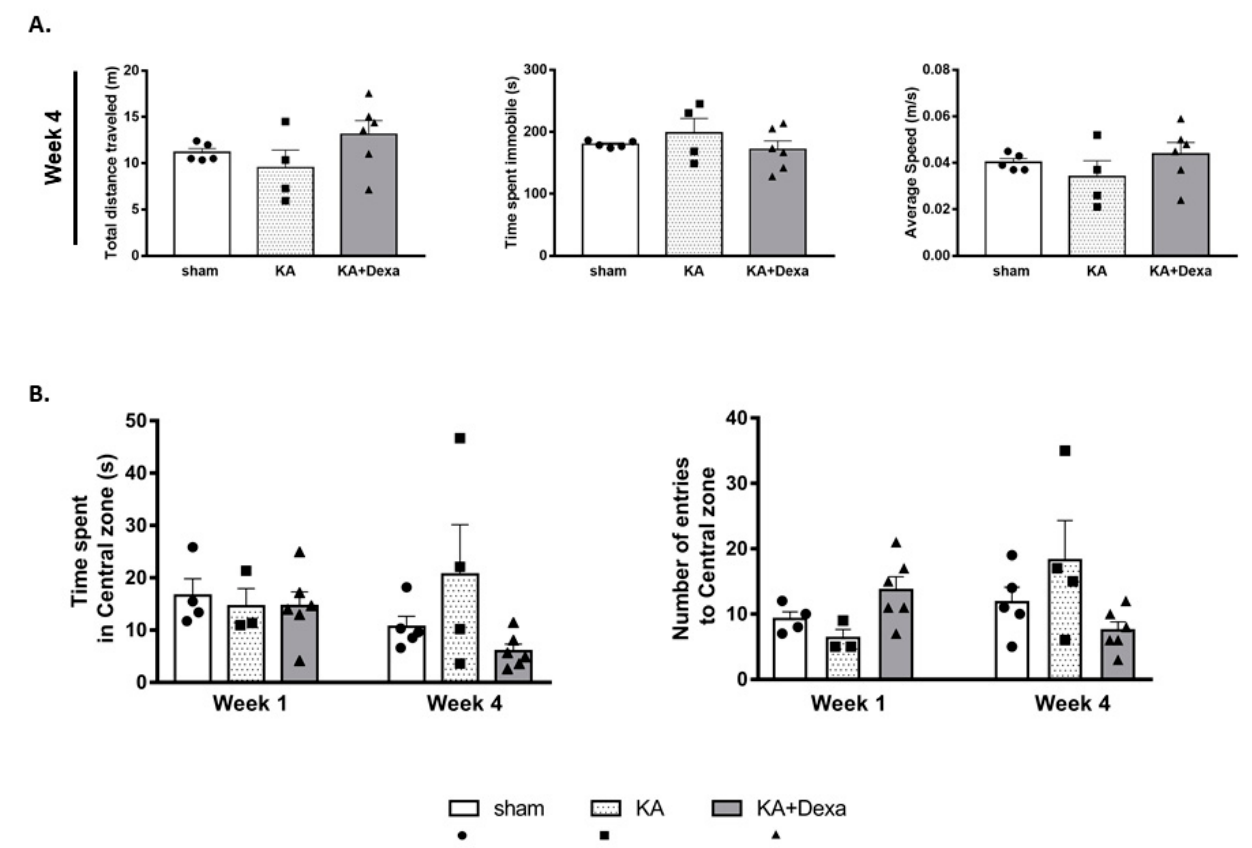
Figure 7. Central zone exploration and mobility in the open field were not affected by KA micro- infusion. ( A ) Graphs representing mobility measures: the total distance traveled by the sham ( n = 5), KA ( n = 4), and KA + Dexa ( n = 6) rats, the total time spent immobile, and the average speed, and ( B ) exploration measures: number of entries to the central zone and total time spent in the central zone at week 1 and week 4 for the sham ( n = 4 and n = 5, respectively), KA ( n = 3 and n = 4, respectively) and KA + Dexa ( n = 6 at both week 1 and week 4) rats.